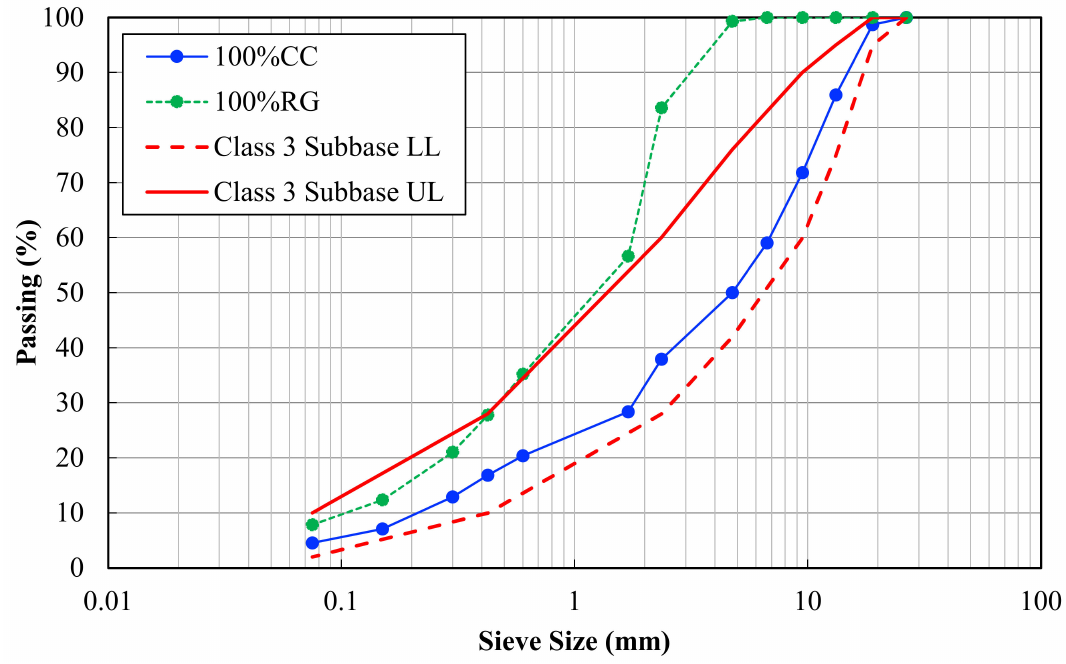
Figure 1. Particle size distribution of the parent